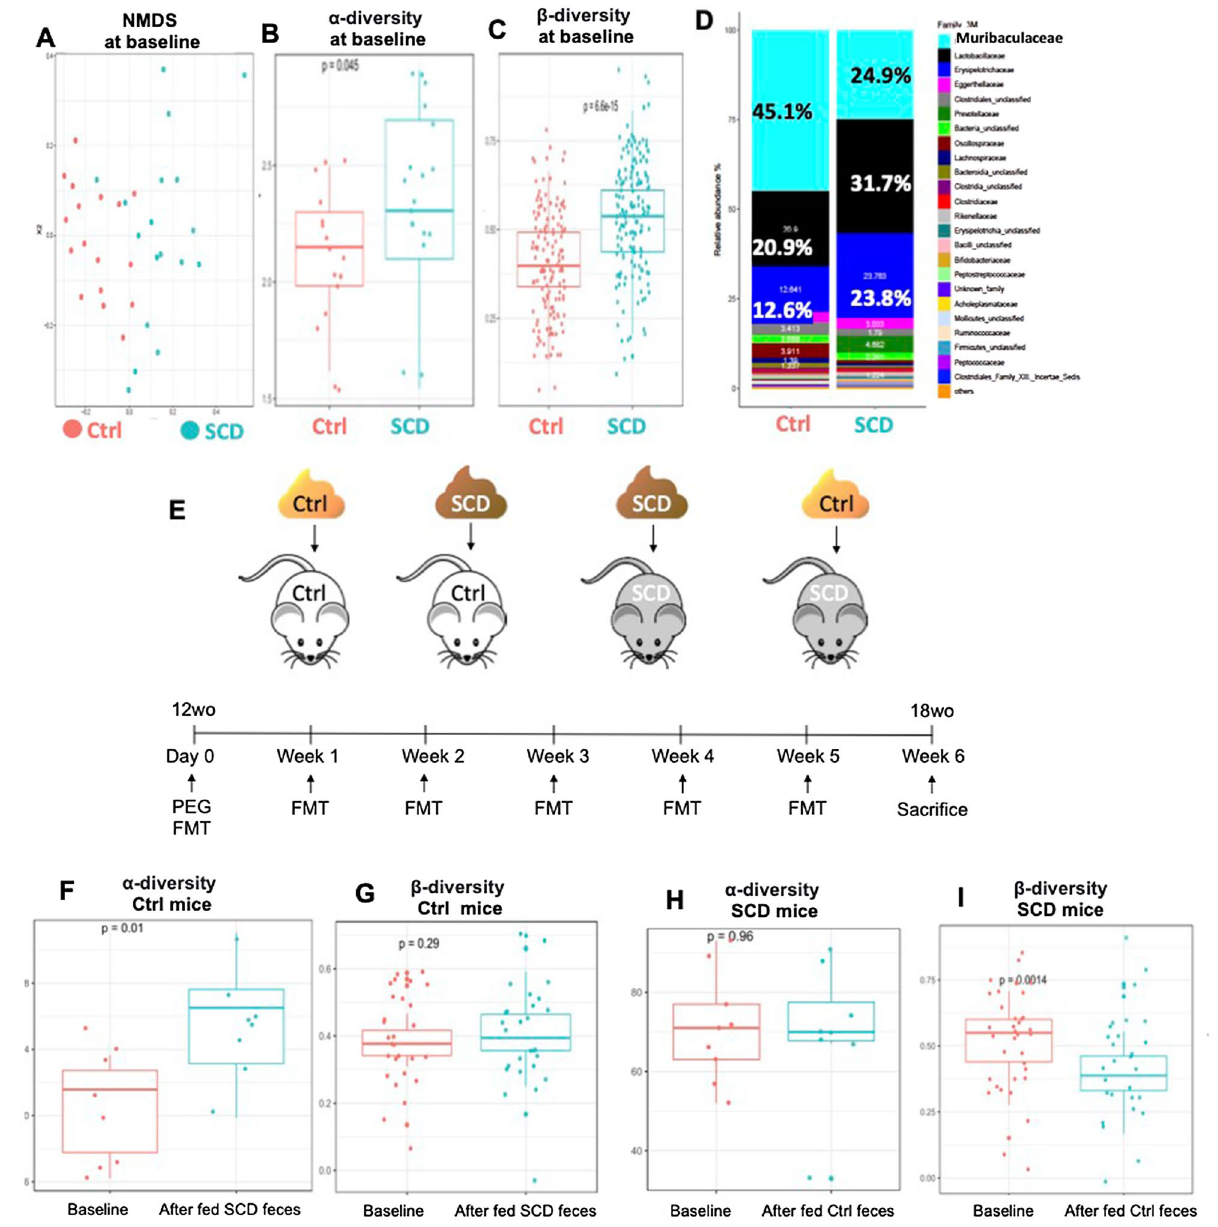
Figure 1. Microbiota composition and reciprocal FMT in Ctrl and SCD mice. ( A – D ) Ctrl and SCD mice have distinct microbiota. Feces were collected from 3-month-old female mice. ( A ) NMDS plots of Amplicon Sequence Variants (ASVs) show that samples from the two groups cluster separately, indicating two distinct microbiota communities. n = 17–18 mice/group. ( B , C ) Analysis of ASVs shows that ( B ) alpha-diversity ( C ) beta-diversity increases significantly in SCD mice. n = 17–18 mice/group. ( D ) Relative abundance of top 25 bacteria families. Data are mean % over total bacteria. n = 17–18 mice/group. ( E ) Scheme of reciprocal FMT to examine whether healthy Ctrl microbiota can ameliorate SCD- related bone loss and from SCD to Ctrl to examine for a pathogenic effect of SCD microbiota on Ctrl mice. Reciprocal FMT was conducted from Ctrl to SCD to examine whether Ctrl microbiota can ameliorate SCD- related bone loss and from SCD to Ctrl to examine for a pathogenic effect of SCD microbiota on Ctrl mice. To prepare RECIPIENT mice for FMT, Ctrl or SCD female mice (3 months old, 10 mice/group) were fasted for 1 h, then mice were given bowel cleansing with four doses of PEG by oral gavage at 20-min intervals to remove the majority of their gut flora to enhance FMT efficiency. To prepare DONOR fecal matter, one fresh fecal pellet per mouse was collected from age and gender matched donor mice (8 mice/genotype) and the pooled whole fecal matter was dissolved in 2 ml of PBS and given by oral gavage 4 h after last PEG treatment to recipient mice. Ctrl recipient receiving Ctrl feces and SCD recipient receiving SCD feces are controls. FMT was conducted once per week with fresh feces collected from donor mice. Six weeks post FMT, bone samples were collected. Similar FMT was also performed on male mice. wo: weeks old. Analysis of ASVs of ( F ) alpha-diversity and ( G ) beta-diversity in Ctrl mice at baseline and after fed SCD feces; ( H ) alpha-diversity and ( I ) beta-diversity in SCD mice at baseline and after fed Ctrl feces. n = 8–9